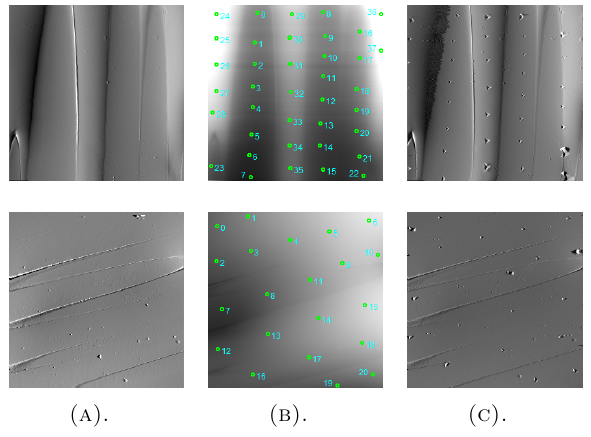
Figure 2. Indentation steps in transverse direction.